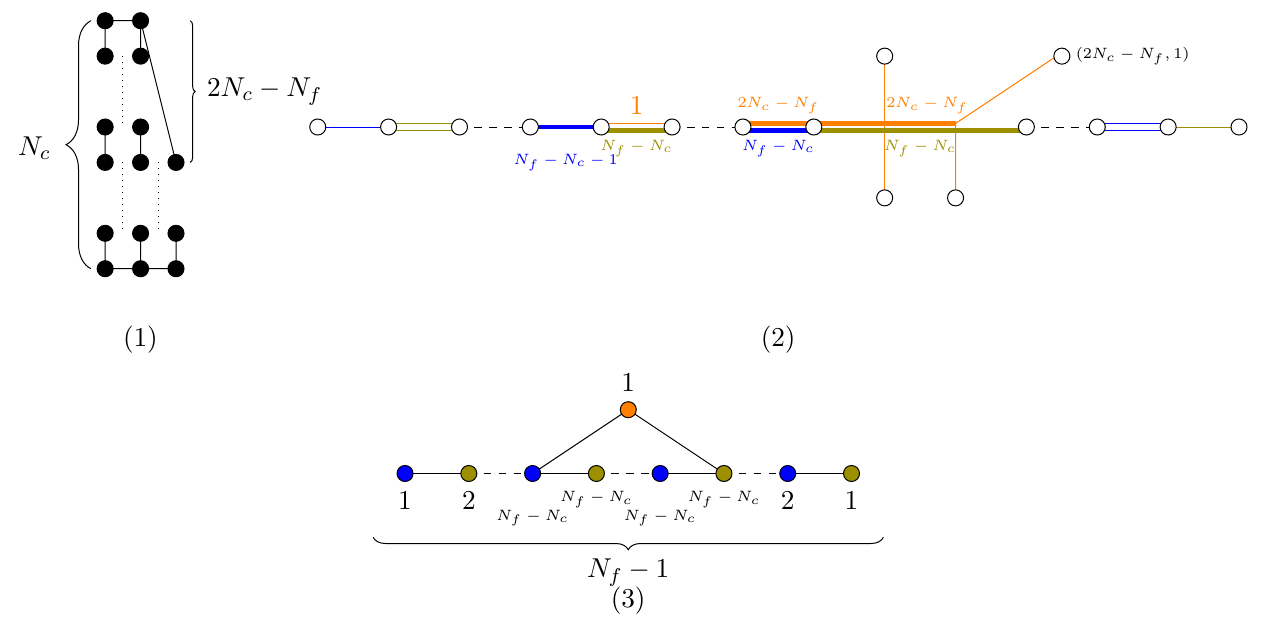
Figure 15 . (1) Toric Diagram representing SQCD with N c < N f < 2 N c indicating the intersection of the Mesonic and Baryonic cone of the Higgs Branch (3) magnetic Quiver whose 3d Coulomb Branch is the intersection of the Mesonic and Baryonic cone of the Higgs Branch of our